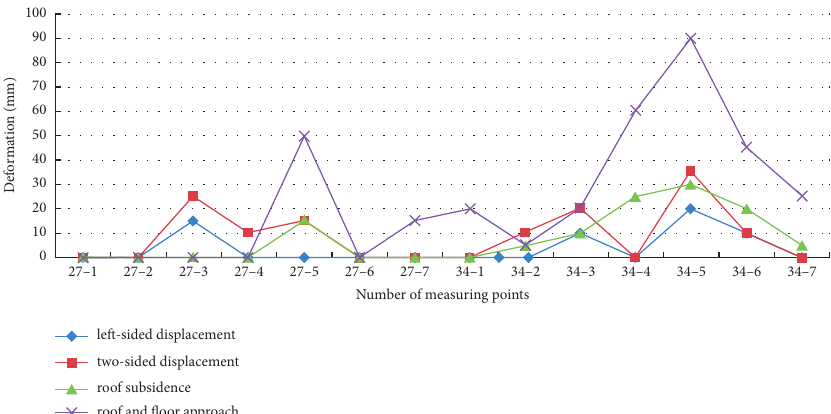
Figure 13: Monitoring curves of the surface displacement.